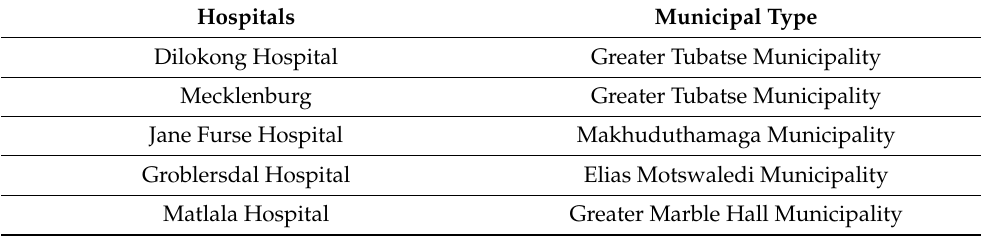
Table 1. Sekhukhune District